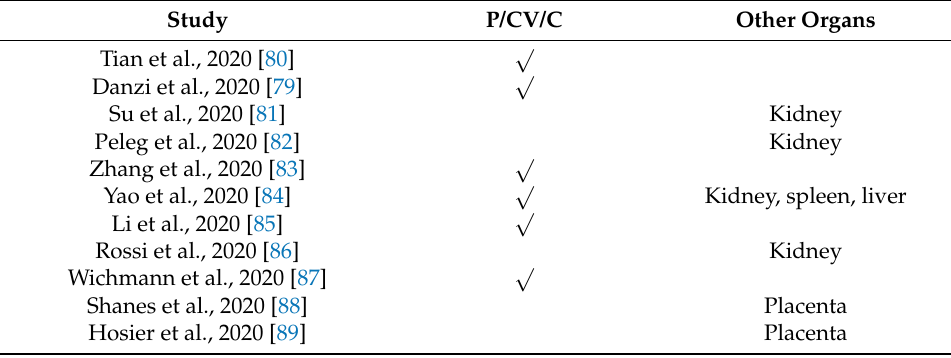
Table A1. Autopsy studies in COVID-19 individuals without brain